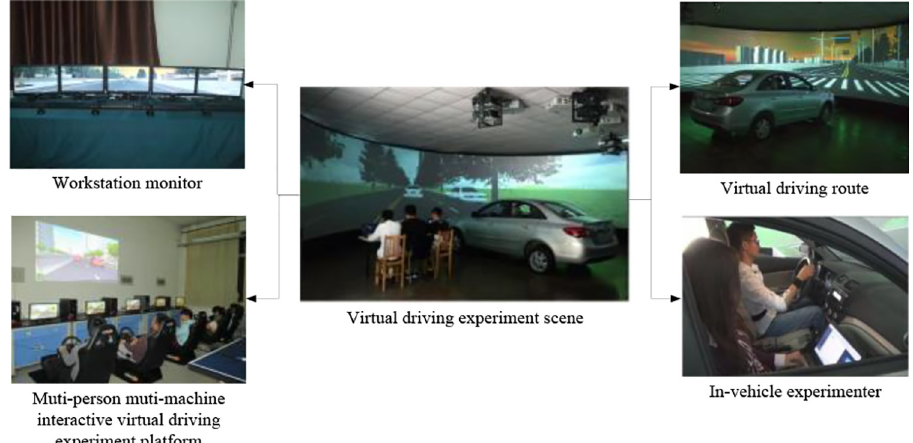
Figure 5 Virtual driving experimental equipment